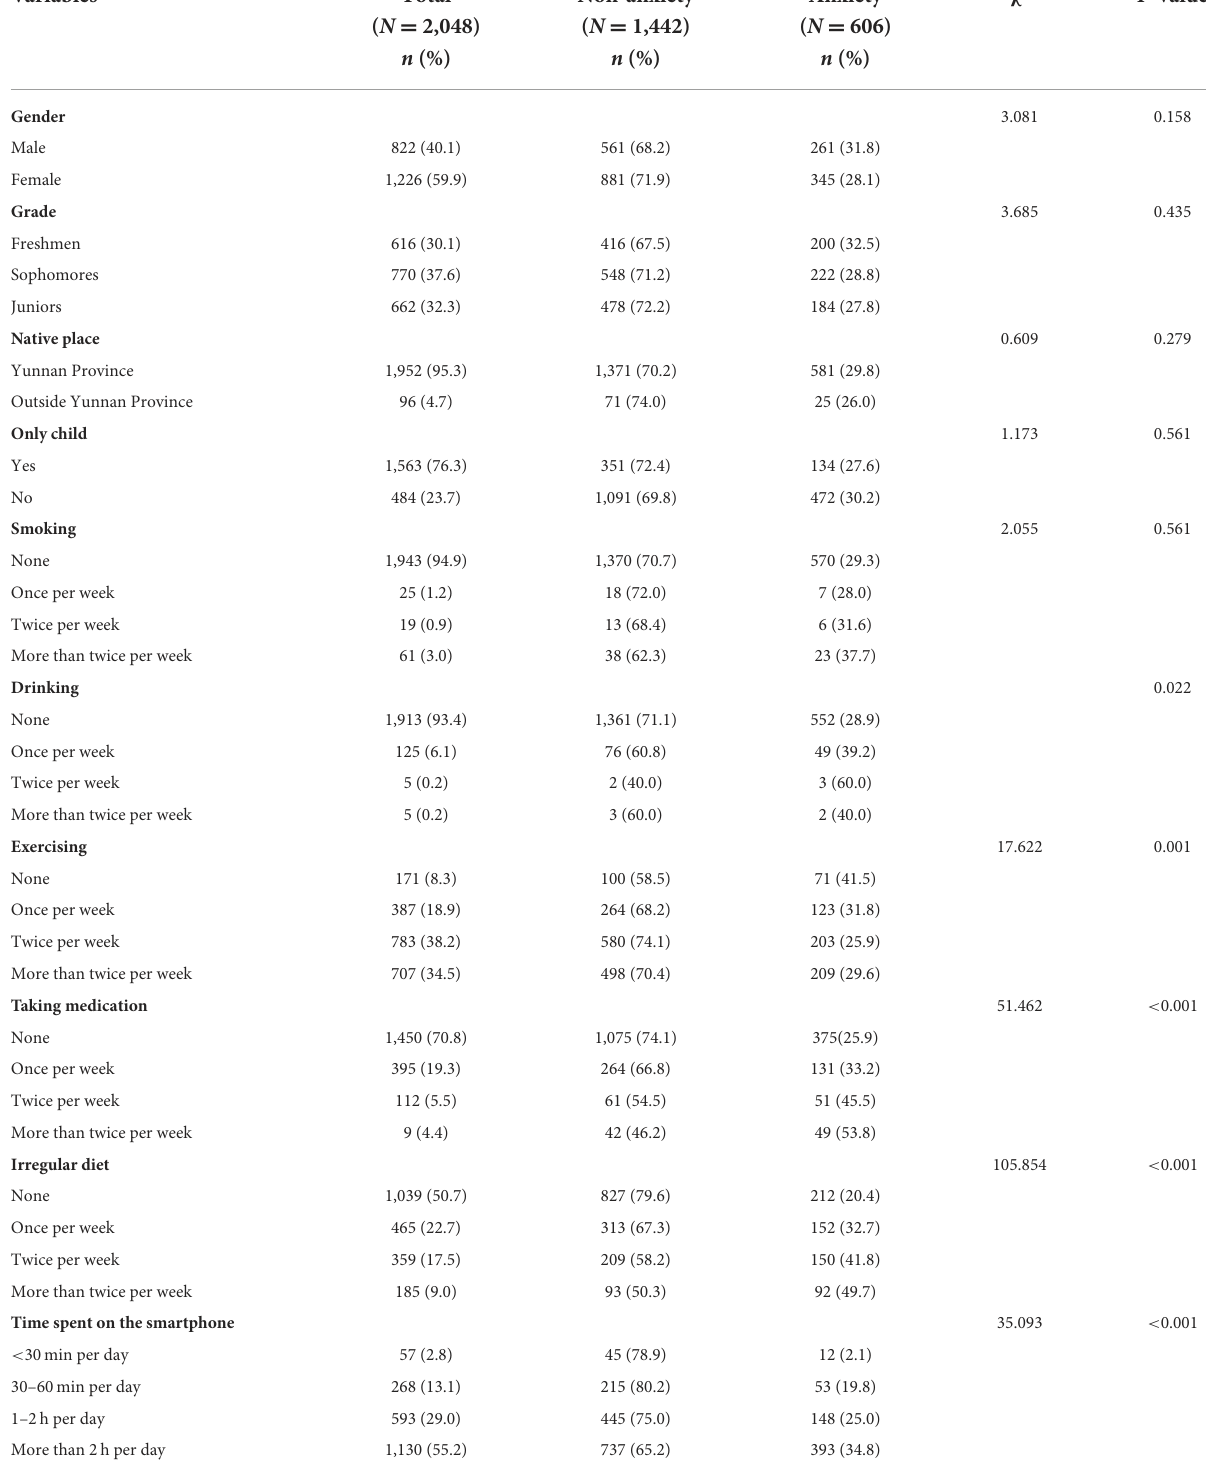
TABLE 2 Characteristics of enrolled students divided into non-anxiety and anxiety groups ( N =